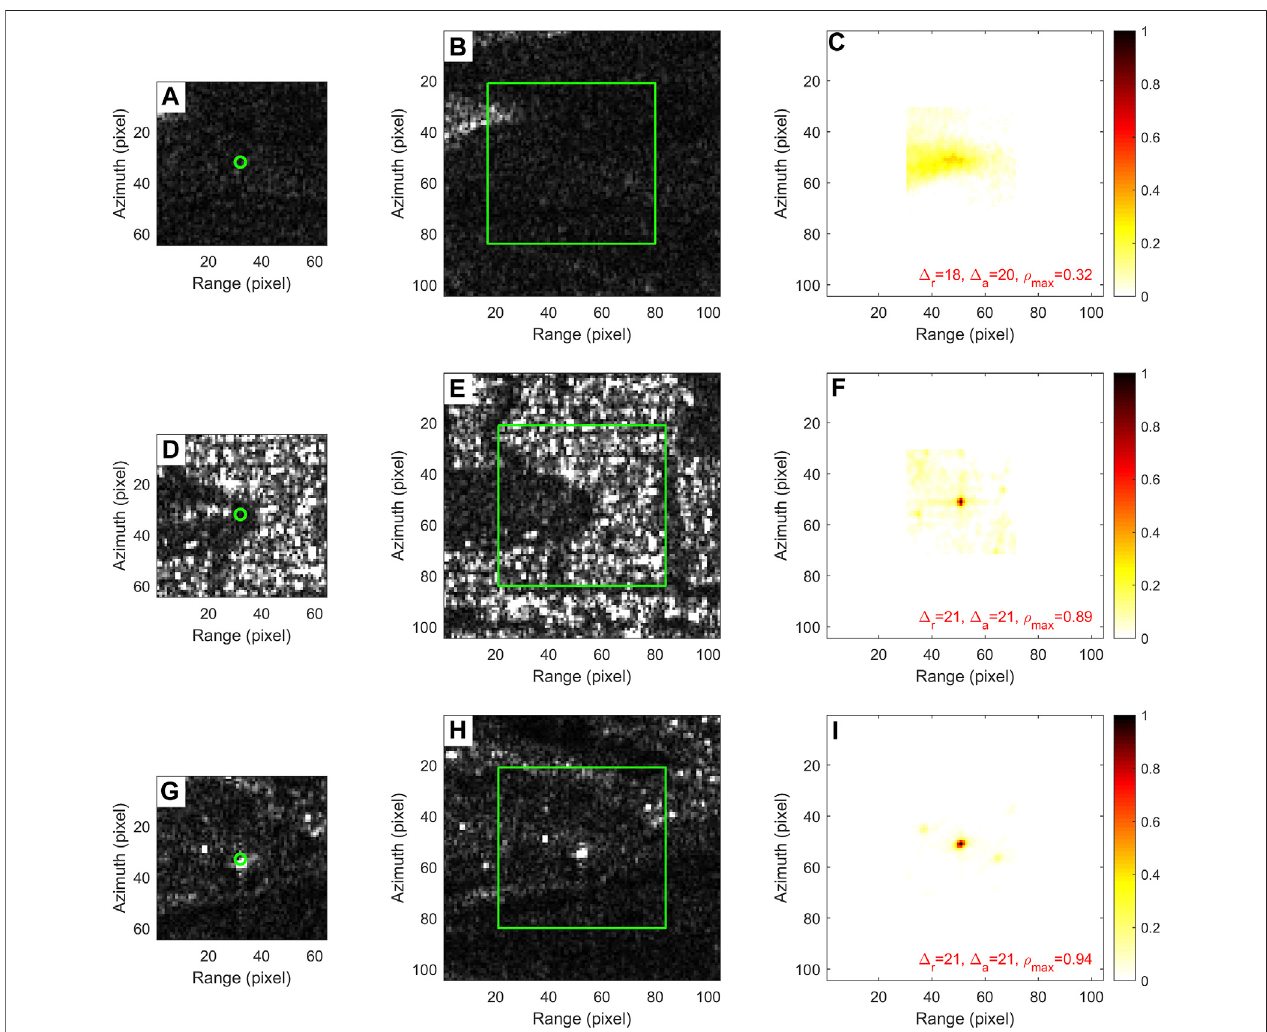
FIGURE 1 | Cross-correlation of three tie points in radar amplitude images. (A) A blindly selected tie point in the green circle and its associated reference matching window. (B) The searching secondary window, in which the green box indicates the corresponding region with the same size of the reference window. (C) The coef fi cients from pixel-by-pixel cross-correlation, in which the red numbers denote range ( Δ r ) and azimuth ( Δ a ) offsets in pixels and the maximum coef fi cient ( ρ max ). The corresponding fi gures for a dark and a bright feature point are shown in (D – F) and (G – I) , respectively.